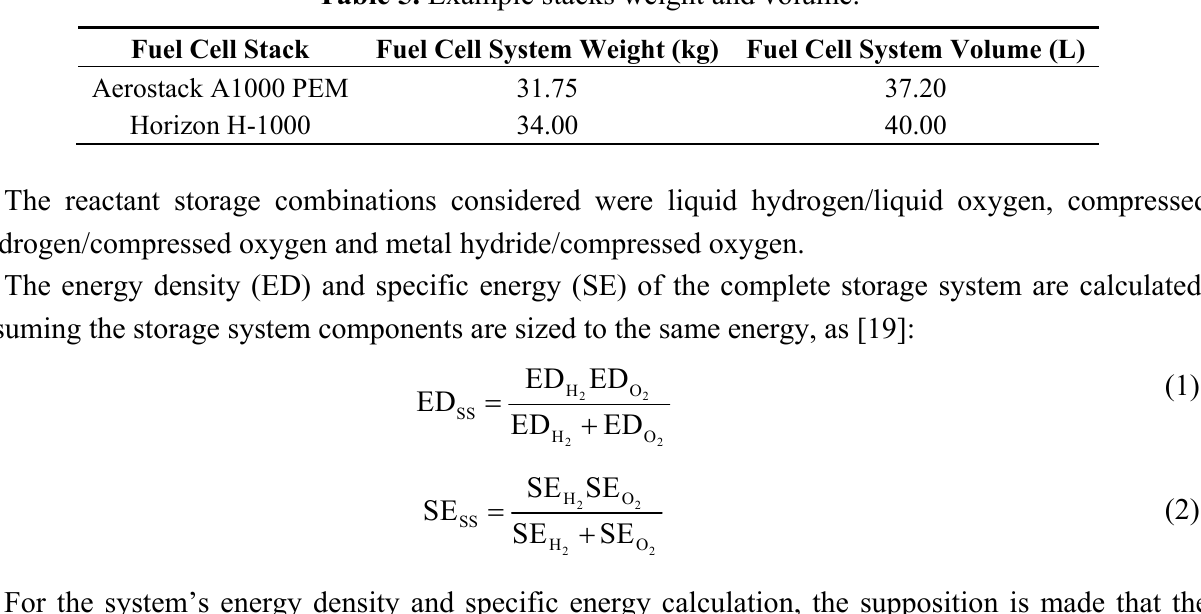
Table 5. Example stacks weight and volume.